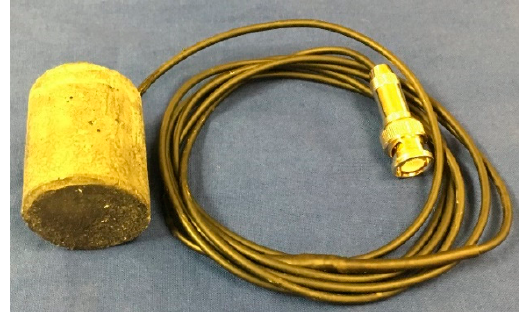
Figure 3. A fabricated tubular smart aggregate (TSA).